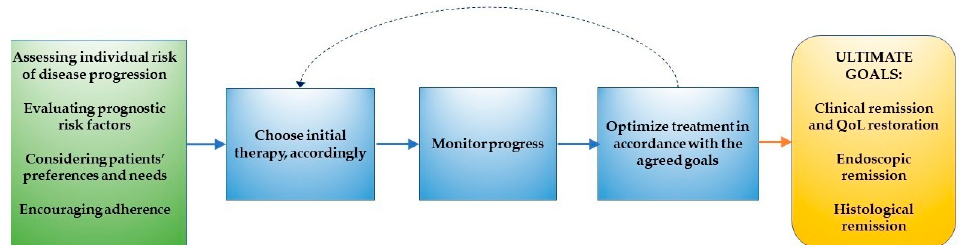
Figure 1. Steps to be taken in order to achieve evolving therapeutic goals according to a treat-to-target approach. QoL: quality of life.